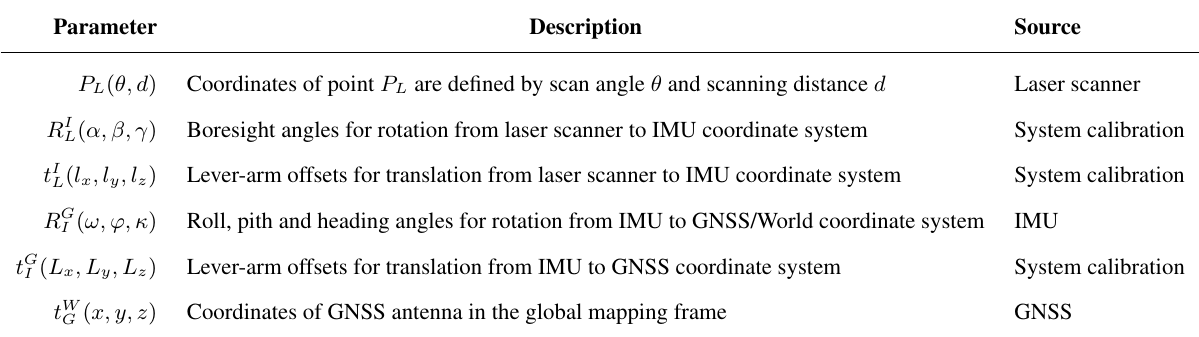
Table 1. Parameters of global transformation of equation (1).